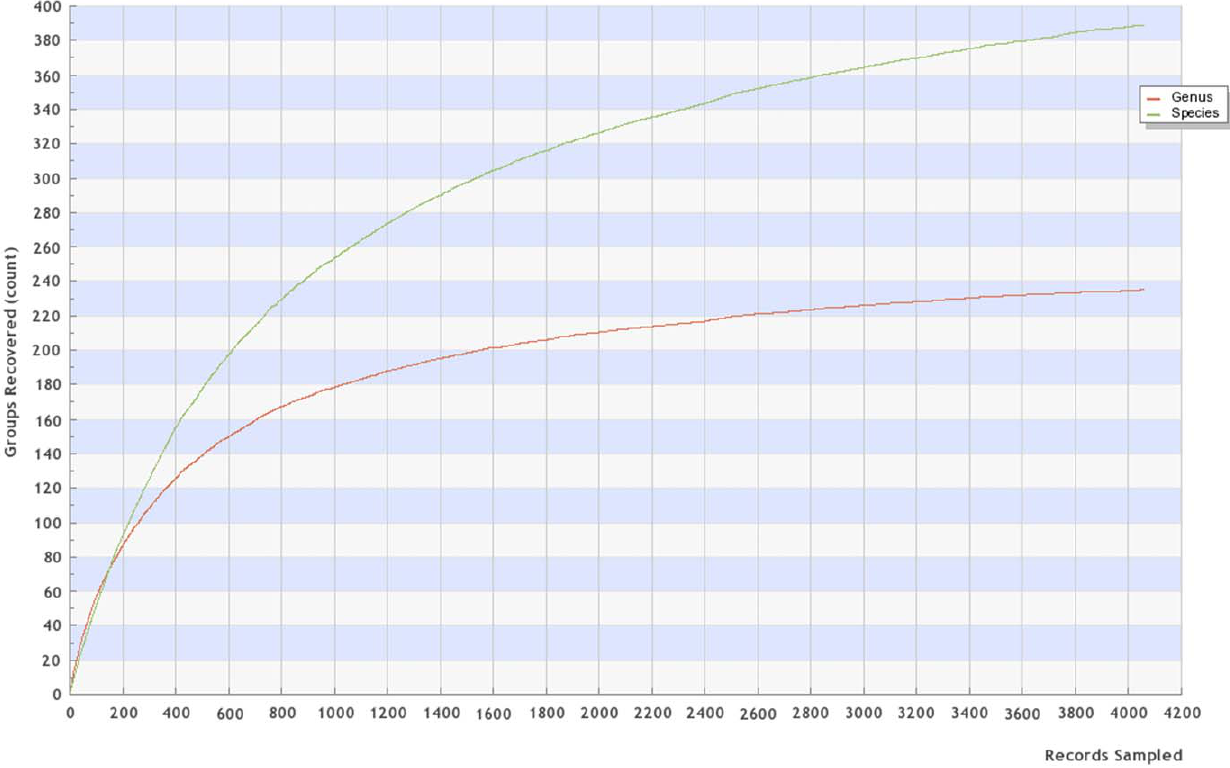
Figure 1. BOLD-generated accumulation curves for specimens in this study. doi:10.1371/journal.pone.0041059.g001 PLoS ONE |